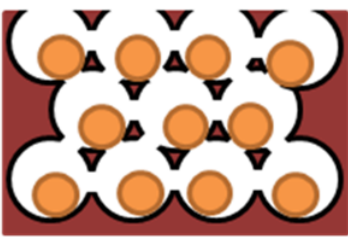
Figure 4. Model of hydrogel inverted colloidal crystal (ICC) scaffold [6].